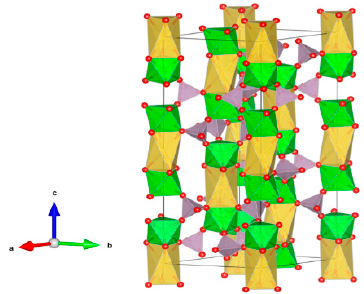
Figure 26. Sodium zirconium phosphate (NZP), NaZr 2 (PO 4 ). Structure rhombohedral, Sp. gr. Rc, R3c,